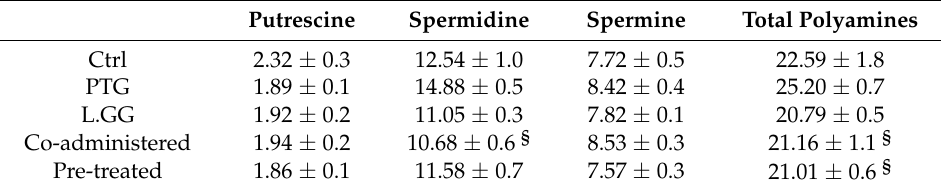
Table 2. Polyamine profile in jejunal tissue samples from control and treated